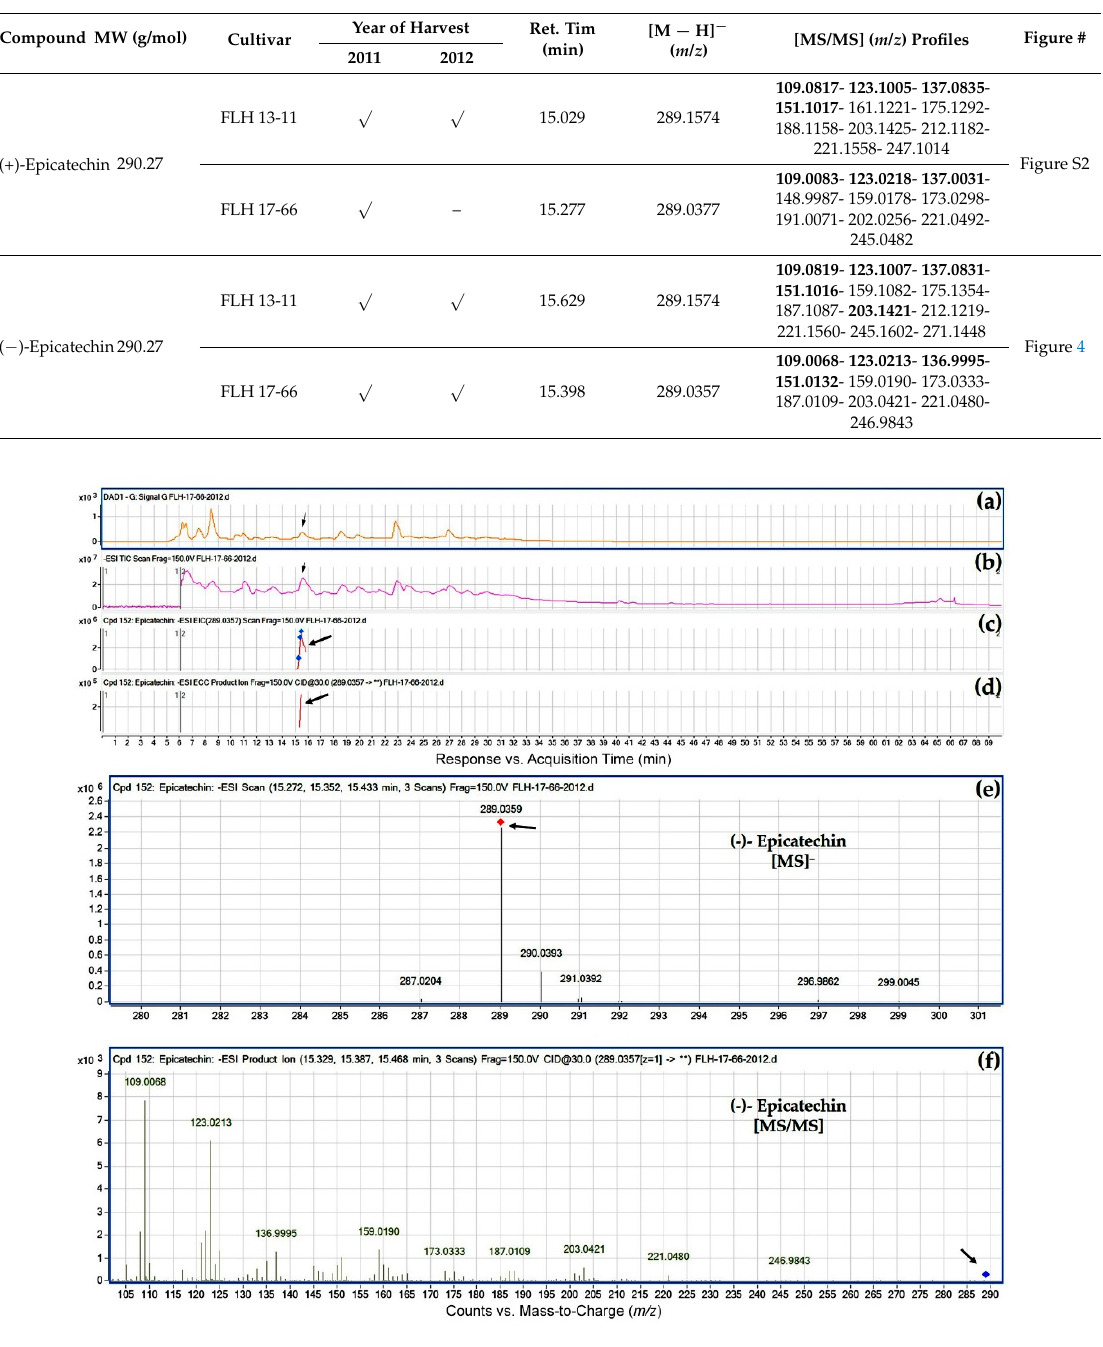
Figure 4. Extracted ion chromatogram (EIC) of primary mass spectrum (MS1) and m / z features of secondary ion fragments (MS2) derived from LC-MC/MS annotate this peak to be ( − )-epicatechin (MW, 290.26). ( a ) Chromatogram of FLH 17-66 extract (2012) recorded at 280 nm; ( b ) total ion chromatogram of FLH 17-66 extract (2012); ( c ) EIC of primary ion 289.0357 [M − H]¯; ( d ) enhanced charge capacity (ECC) ion product for m / z 289.0357; ( e ) a MS profile showing an extracted m / z value, 289.0359; and ( f ) fragments from collision-induced dissociation (CID) of m / z 289.0359 showing m / z 109.0068, 123.0213, 136.9995, 151.0132, 203.0421, and 246.9843 (Table 1).